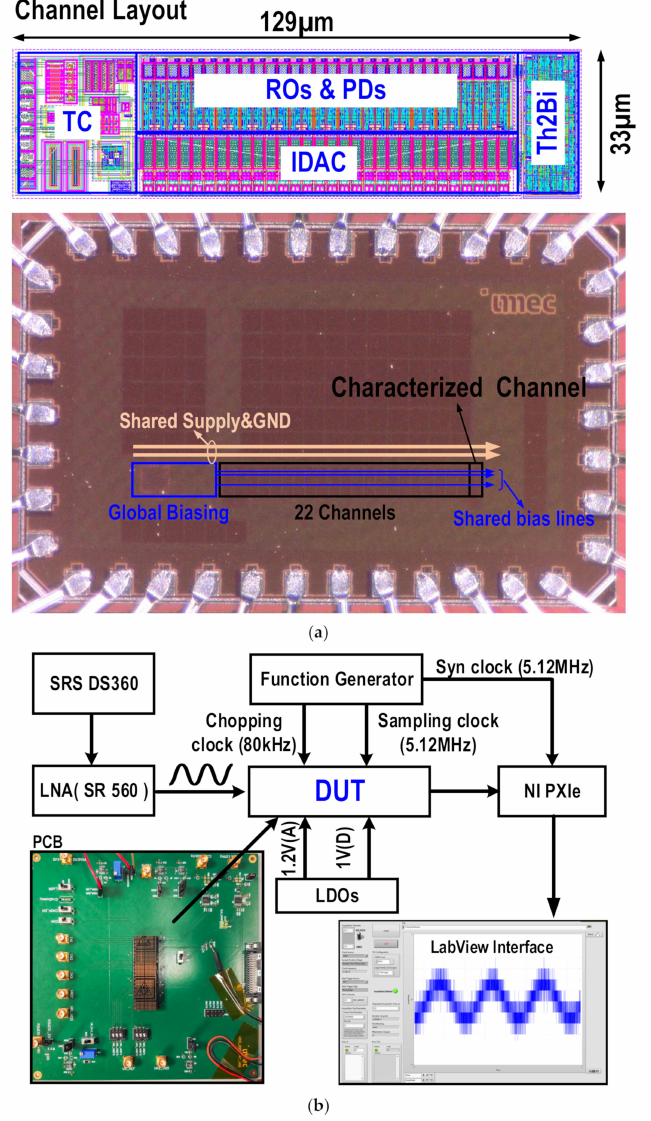
Figure 3. ( a ) Chip micrograph and details of channel layout. ( b ) Diagram of test setup and picture of test